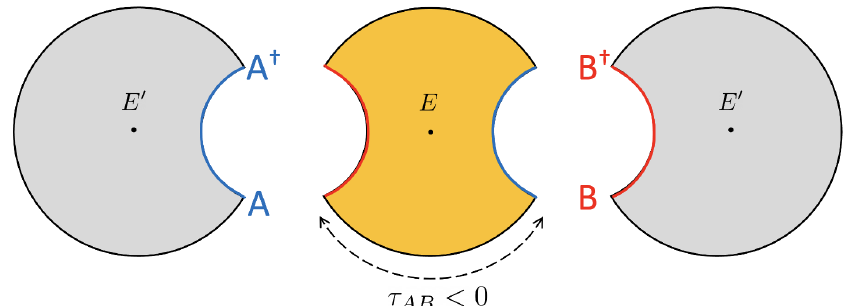
Figure 5 . Two shell solution for E > E 0 . The central region involves negative euclidean time evolution. Lines of the same color are identified. This means that the euclidean time separation τ AB between A and B along the boundary of the yellow region is negative